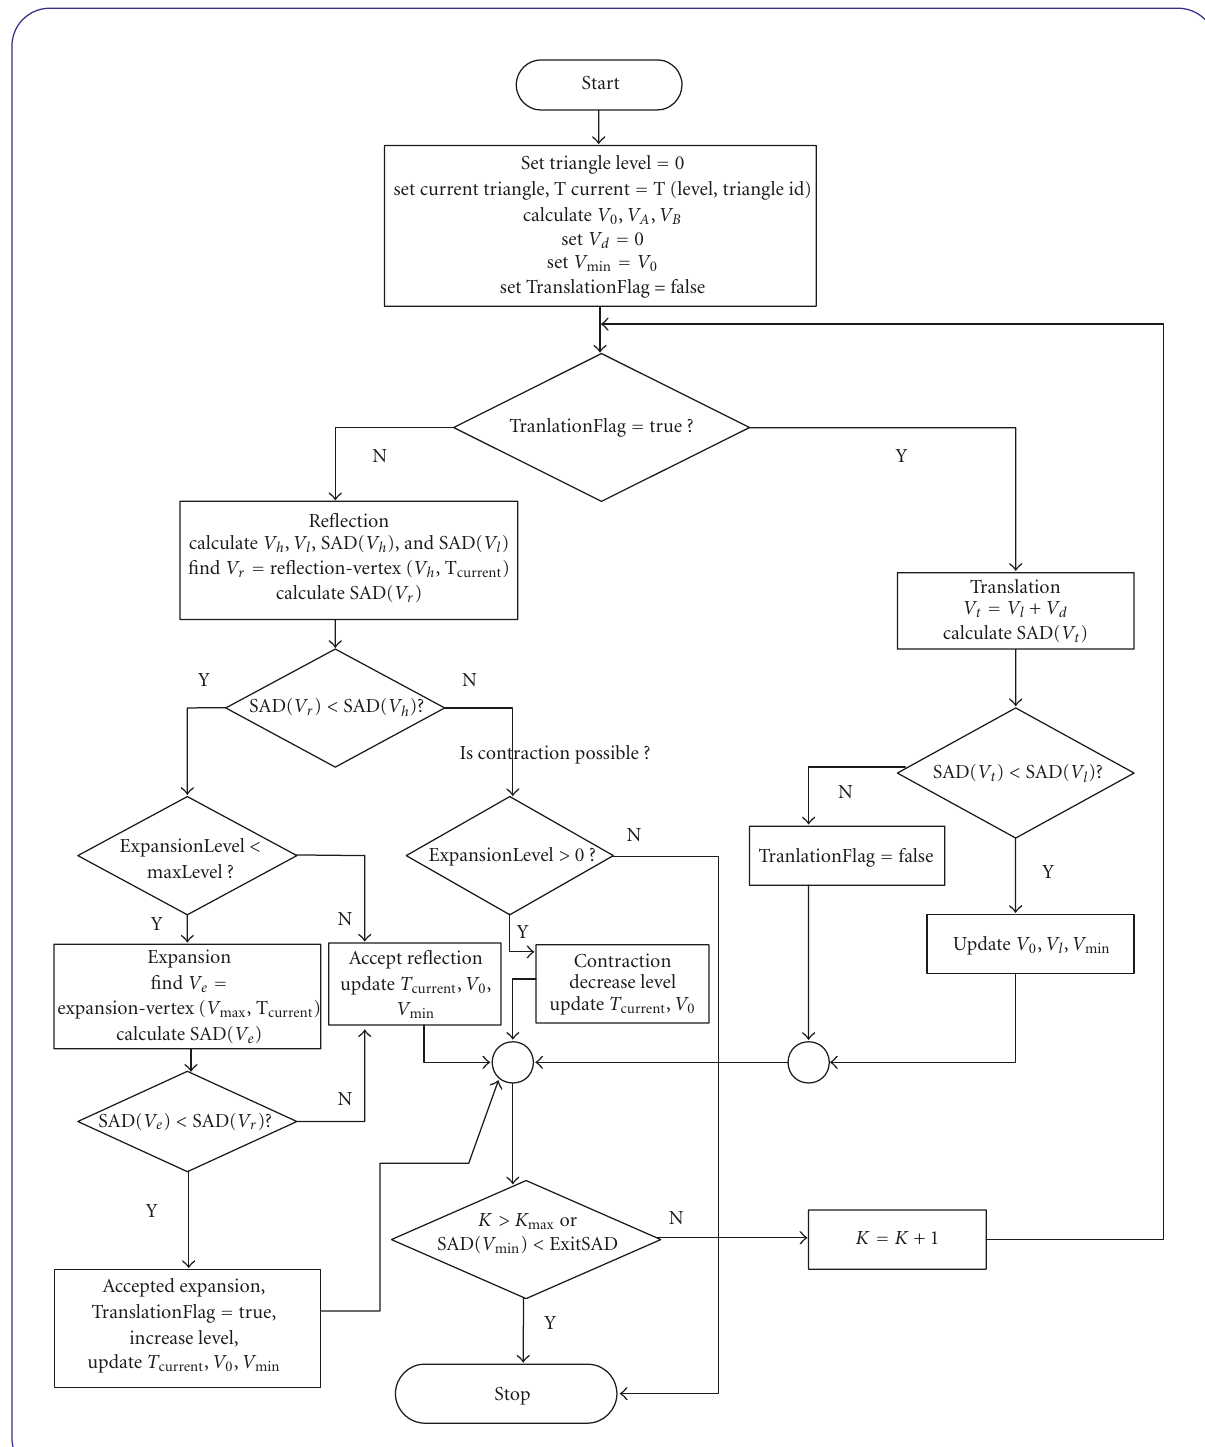
Figure A.2: Flowgraph of the FTS